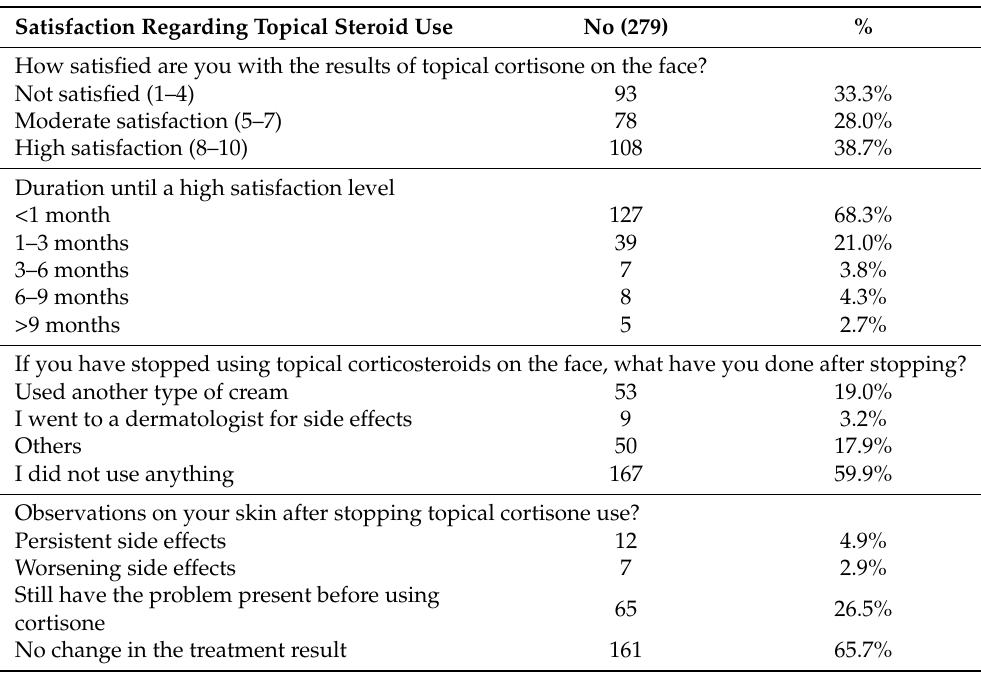
Table 3. Distribution of participants’ satisfaction regarding topical steroid use.